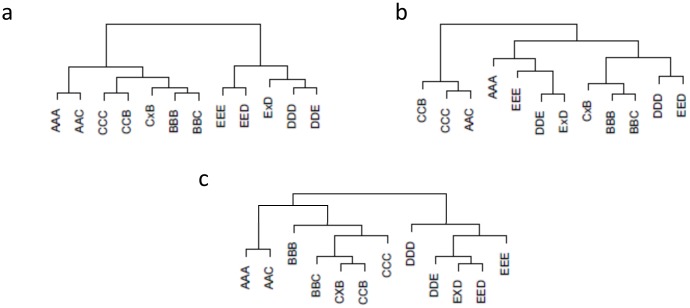
Typical dendrograms obtained for plasmode datasets from MSUPRP experimental data with two dissimilarity measures.Dendrograms using complete linkage based on (a) Poisson dissimilarity (poi), (b) Euclidean distance calculated from raw normalized data (rnr), and (c) reference dissimilarity based on maximum proportion of shared reads. Original samples are labeled with 3 same letters (AAA, BBB, CCC, DDD or DDD), synthetic samples are labelled with 2 or 3 letters symbolizing the proportion of transcripts, ½ or ⅓ respectively, taken from the original samples. Dendrogram (a) clustered original samples A, B and C and their synthetic combinations in one group, and original samples E and D and their synthetic combinations in another group. The hierarchical structure of each of these two groups represented the degree of shared reads between samples by joining first samples that shared ⅓ of reads and then samples that shared ½ of reads. Dendrogram (b) did not cluster samples according to the expected configuration.